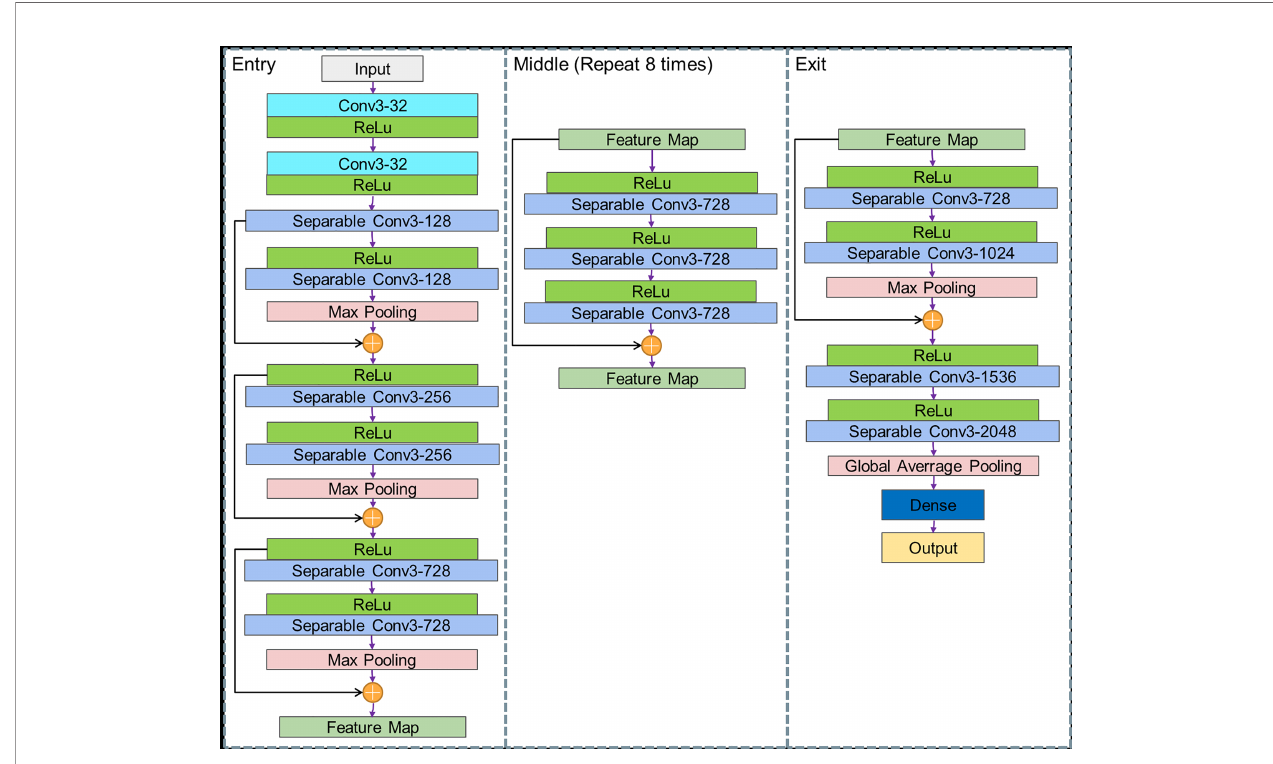
FIGURE 4 | Structure of